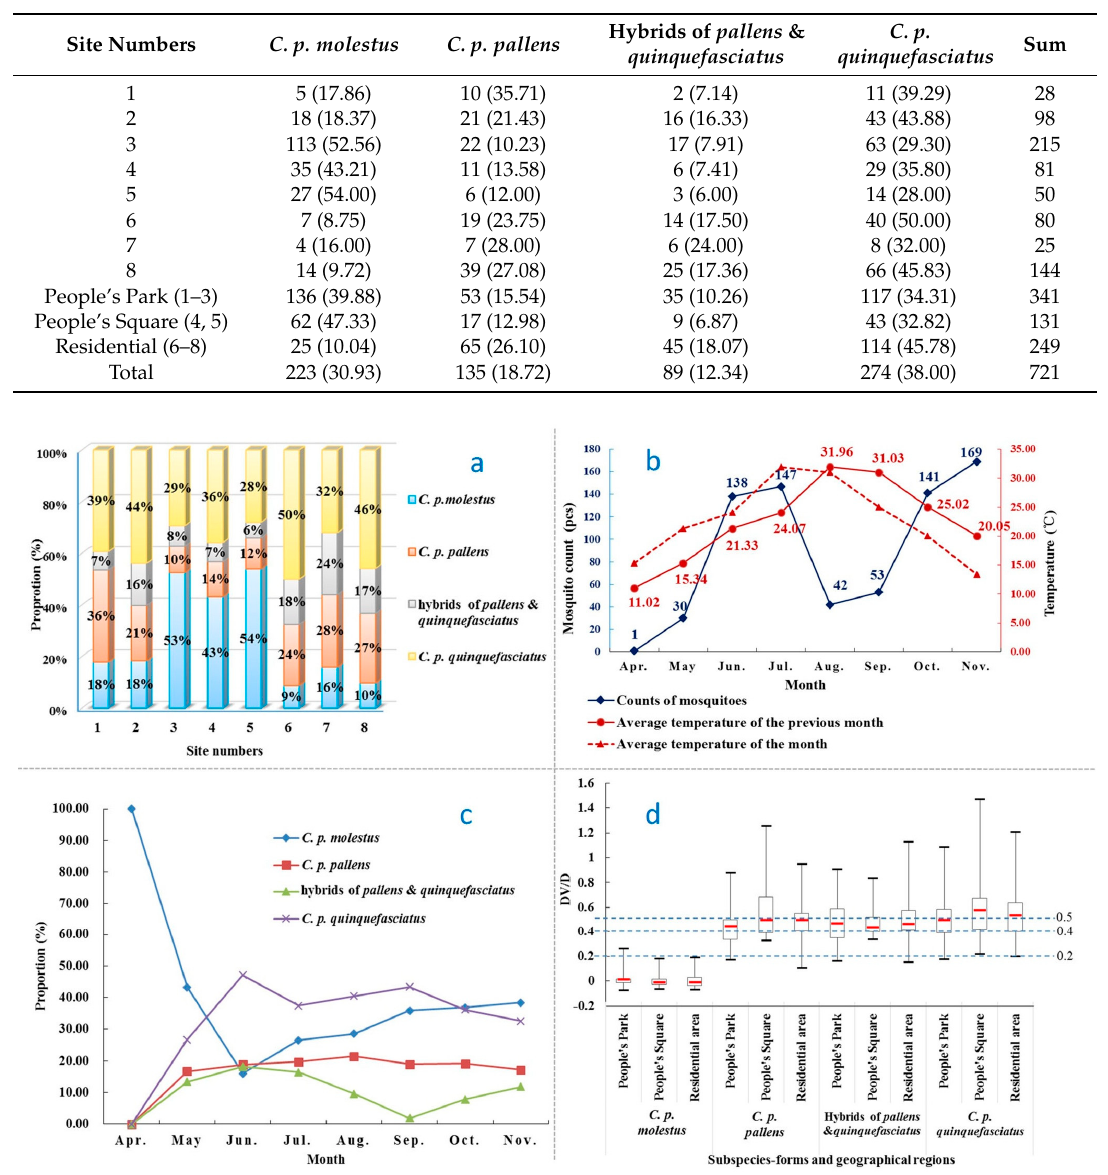
Table 2. Composition and distribution (Counts/pcs, proportion/%) of Culex pipiens complex mosquitoes in downtown Shanghai.